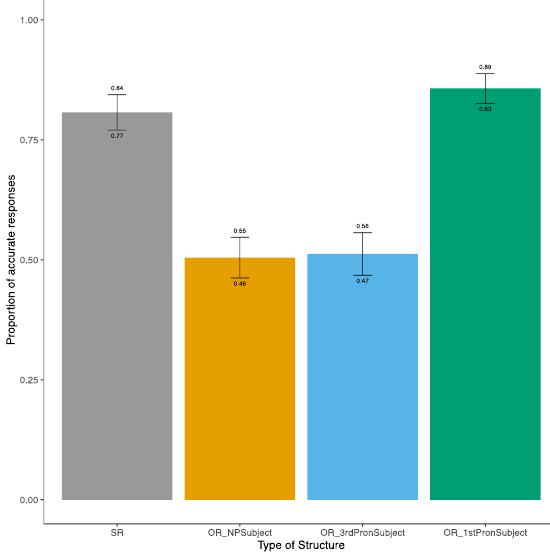
Figure 3. Proportion of correct responses for subject and object relatives, with 95% confidence